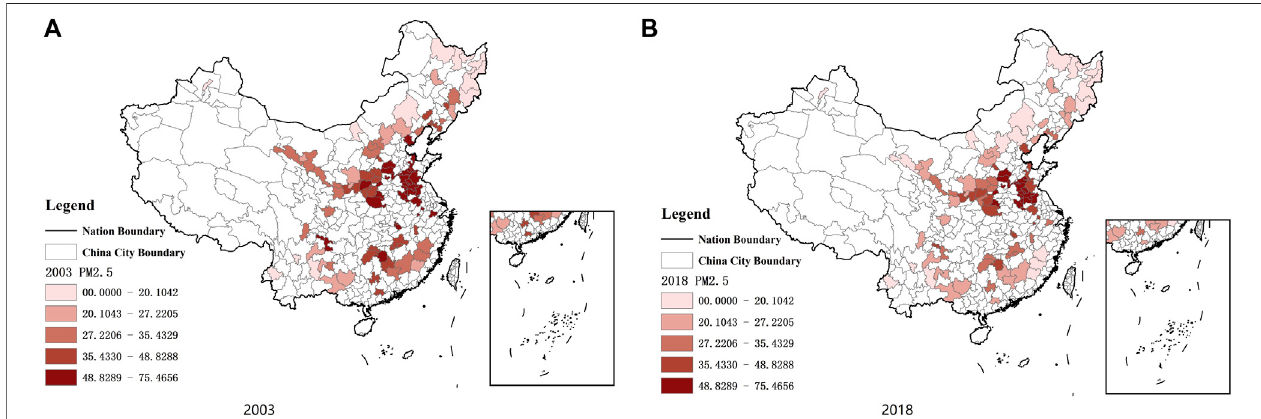
FIGURE 1 | Emission concentration of PM 2.5 in resources-dependent cities in 2003 (A) and 2018 (B) .